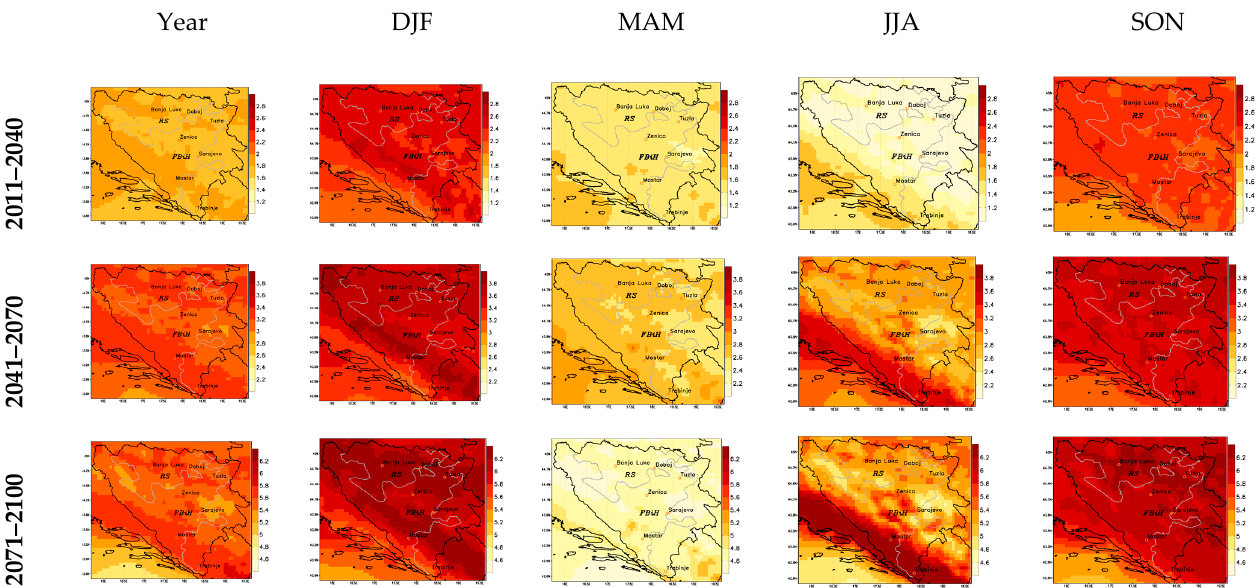
Figure 1. Change of mean annual and seasonal (DJF, MAM, JJA and SON) air temperatures, for the periods 2011–2040, 2041–2070 and 2071–2100 in relation to the period 1971–2000, according to the future climate scenario